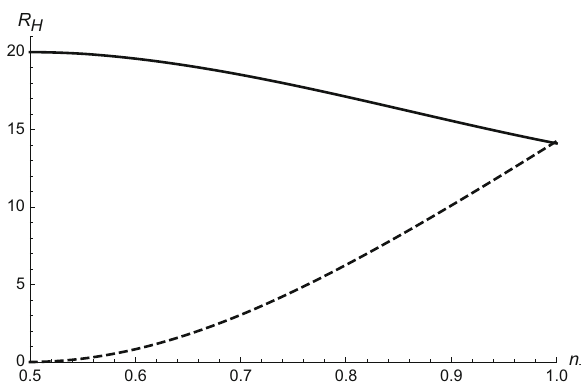
(cid:6) ( solid line ) and (cid:7) ˆ R ( − ) H